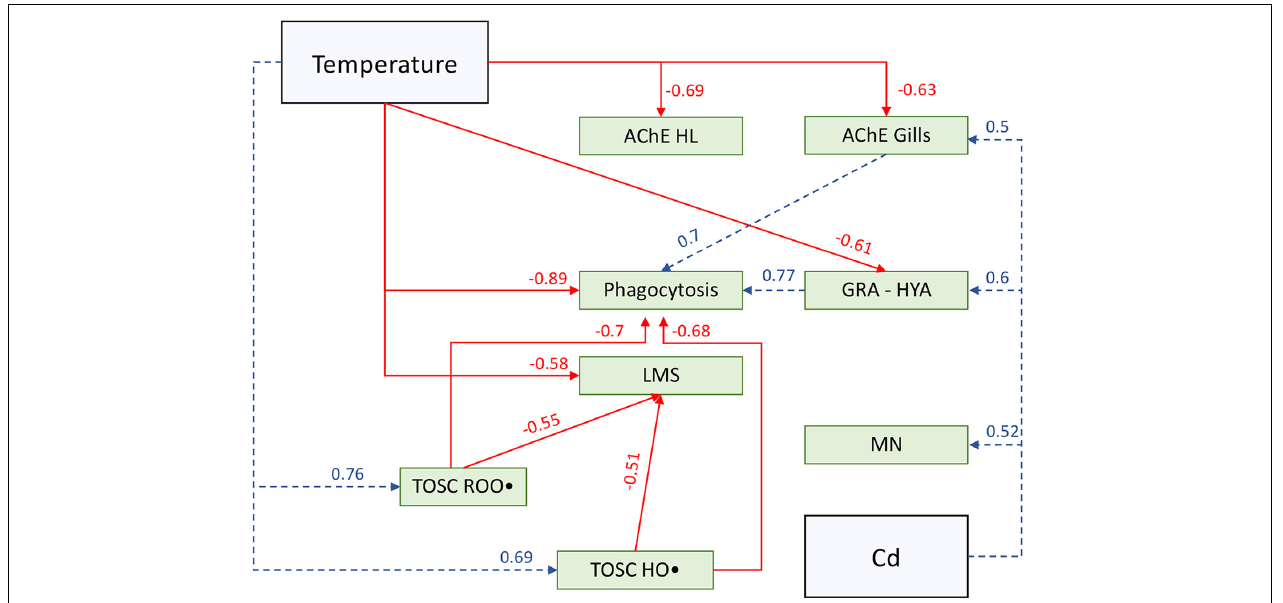
FIGURE 6 | Schematic overview of putative cascade of effects among tested stressors (blue squares) and biological parameters (green squares) based on significant ( p < 0.05) correlation coefficient (Pearson correlation analysis) and discussed hypotheses. Solid red lines represent significant negative correlations, while dotted blue lines represent significant positive correlations; arrows direction is based on putative cause-effect relationships. AChE HL, acetylcholinesterase activity in hemolymph; AChE Gills, acetylcholinesterase activity in gills; Phagocytosis, hemocytes phagocytosis rate; GRA-HYA, granulocytes on hyalinocytes ratio; LMS, hemocytes lysosomal membrane stability; MN, hemocytes micronuclei frequency; TOSC ROO • , total oxyradical scavenging capacity toward ROO • in gills; TOSC HO • , total oxyradical scavenging capacity toward HO • in gills; Temperature, exposure temperature scenario; Cd, cadmium